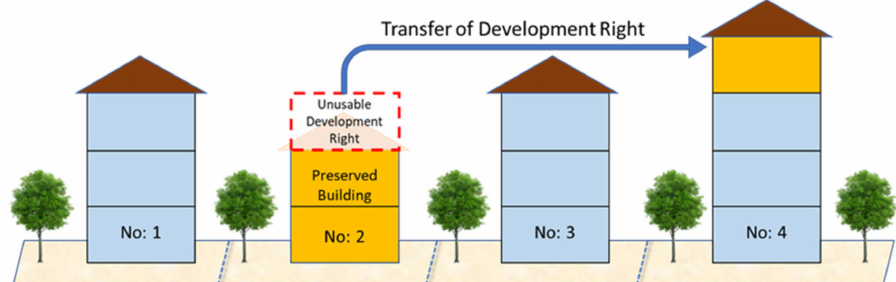
Figure 6. Transfer of restricted floor area onto another parcel (from building No: 2 to building No: